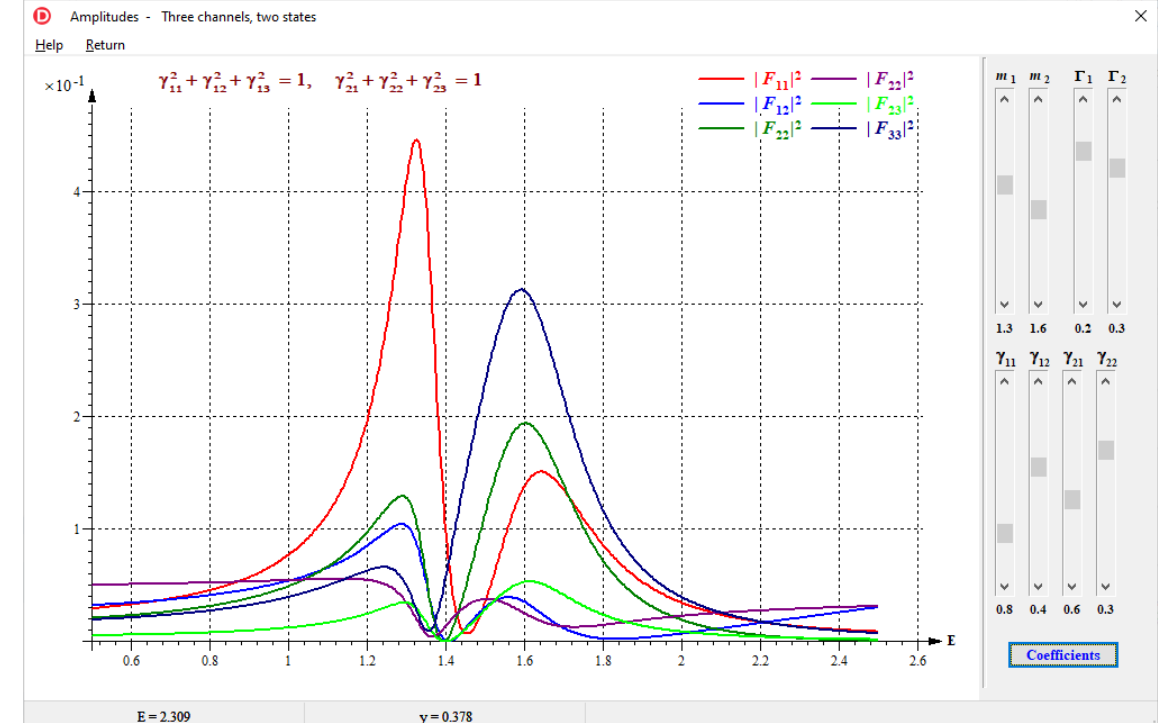
Figure A3. K -matrix scattering amplitudes